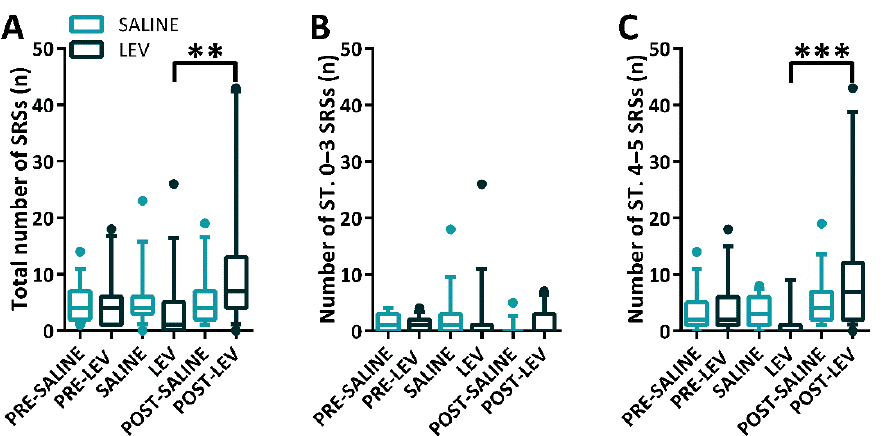
Figure 3. Weekly occurrence of spontaneous recurrent seizures (SRSs) in epileptic rats treated with levetiracetam (LEV) or saline. All rats ( n = 30) were treated with LEV ( n = 15) or saline ( n = 15). In ( A ), the discontinuation of LEV significantly induced the rebound effect. In ( B ), LEV displayed no significant effects on stage 0–3 SRSs. In ( C ), LEV significantly induced rebound phenomena of stage 4–5 SRSs after its discontinuation. The whiskers of the boxes represent the 10–90th percentile. ** p < 0.01, *** p < 0.001, Tukey’s test, LEV vs POST-LEV. ST., stage.